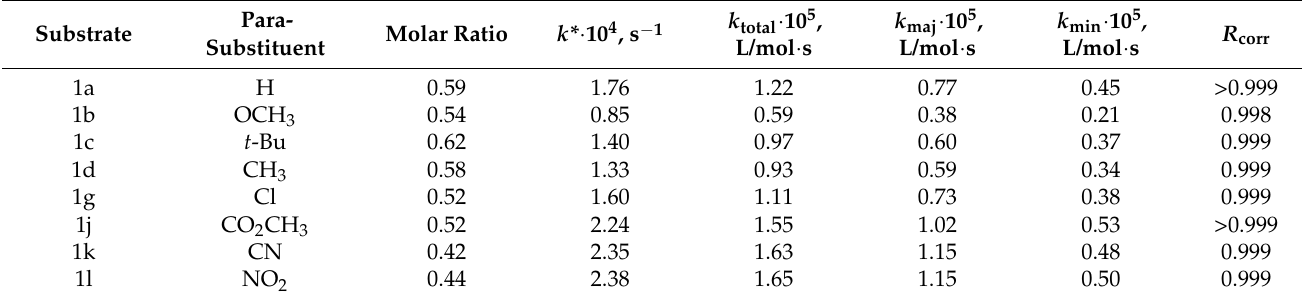
Table 2. Kinetic data of the reactions of nitrostyrenes 1 with